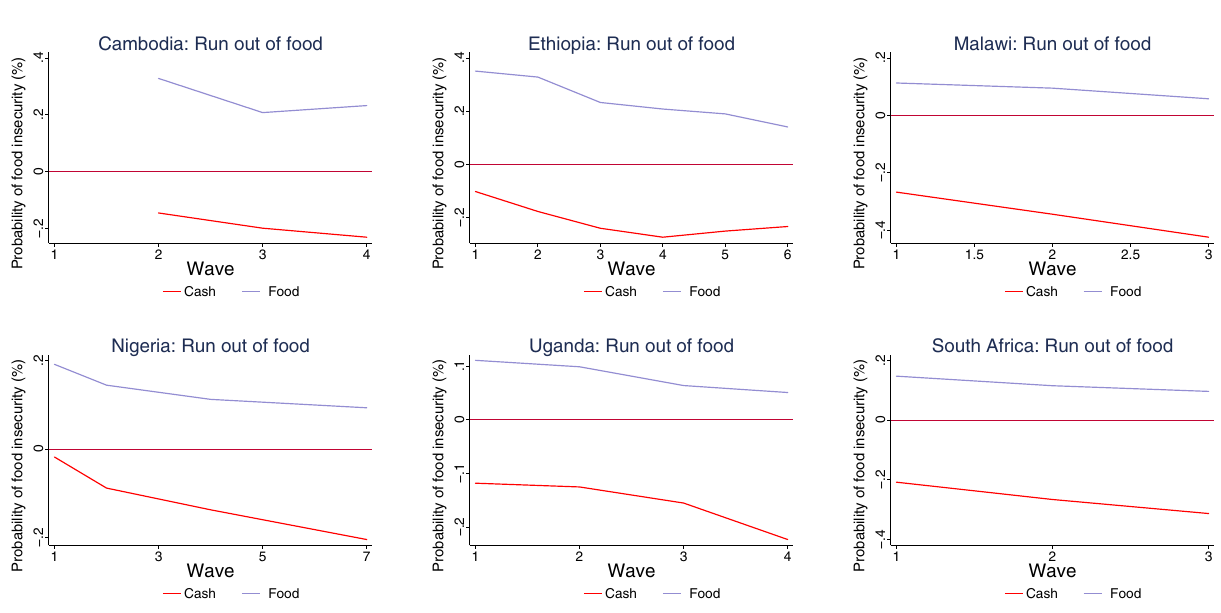
Figure 7. Impact of safety nets on food insecurity (run out of food) by